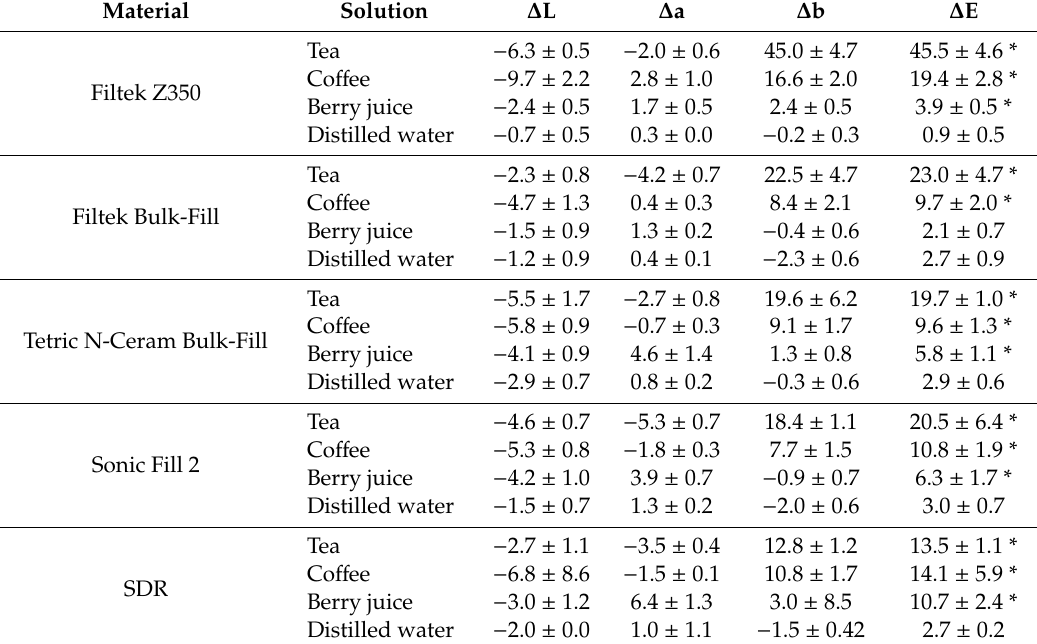
Table 3. Means and standard deviations of CIE Lab parameters for the materials tested in the four solutions after 90 days of immersion. ∆ L: changes in lightness and darkness, ∆ a: changes in the red-green axis, ∆ b: changes in the blue–yellow axis, ∆ E: overall shade change. Material